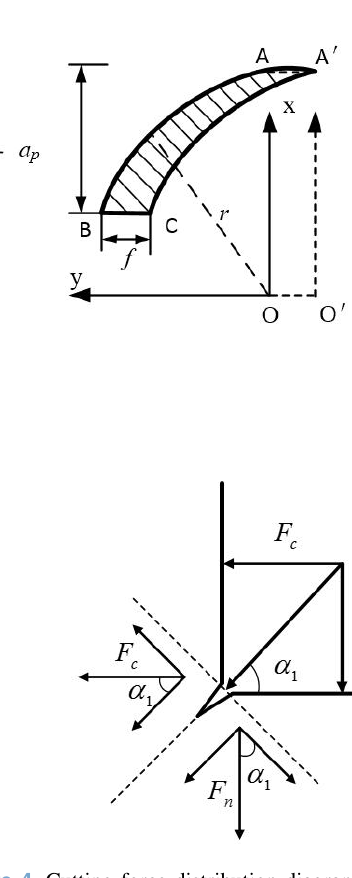
Figure 3. Path diagram of crack propagation for crushing removal. Figure 4. Cutting force distribution diagram for the first stage of crack propagation.